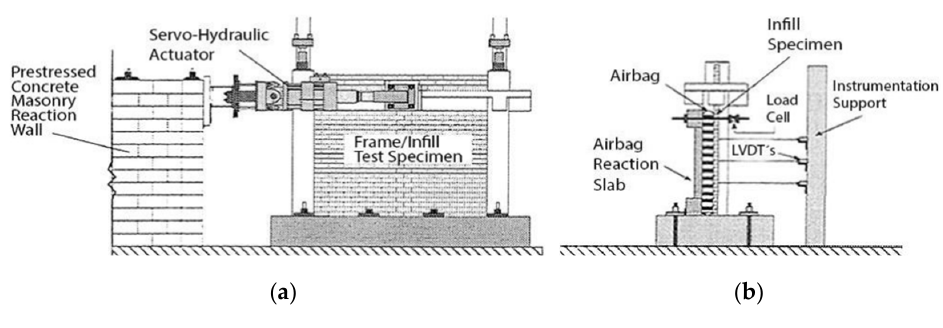
Figure 3. Testing setup [10]: ( a ) in-plane test; ( b ) out-of-plane test.